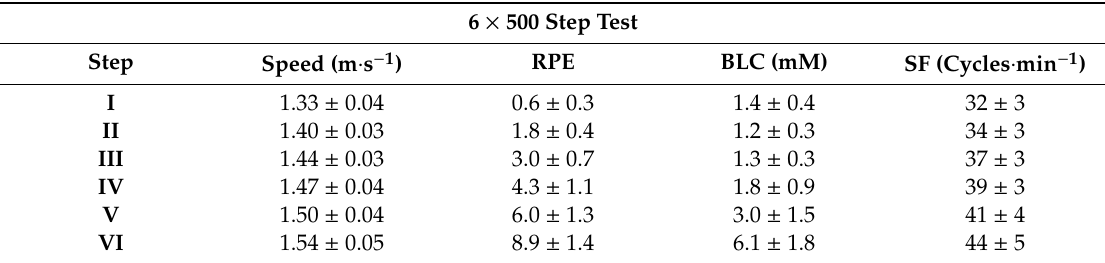
Table 1. Mean speed, rating of perceived exertion (RPE), blood lactate concentration (BLC), and stroke frequency (SF) for each step of the incremental tests.